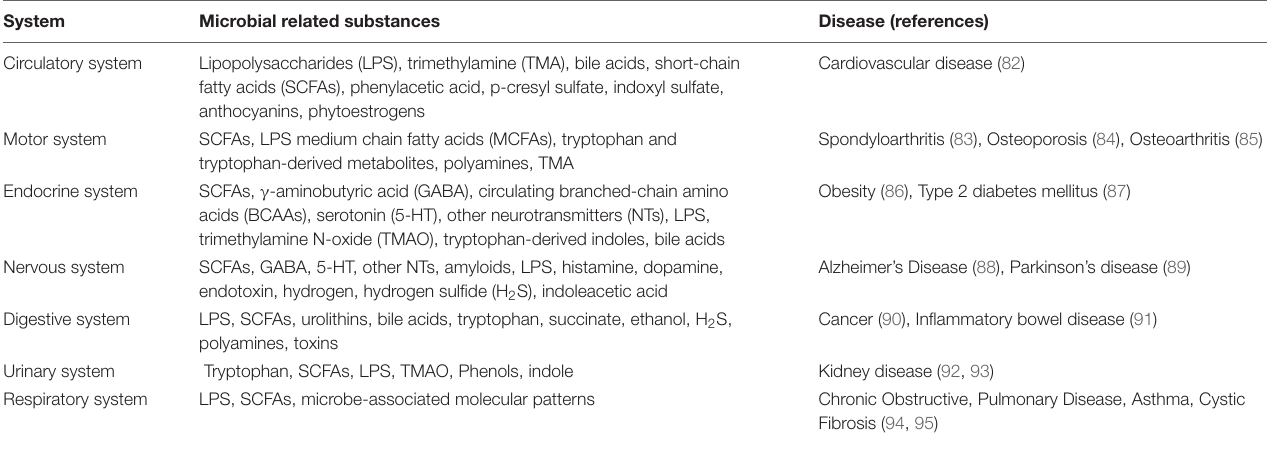
TABLE 1 | The microbial metabolites and compositions associated with human